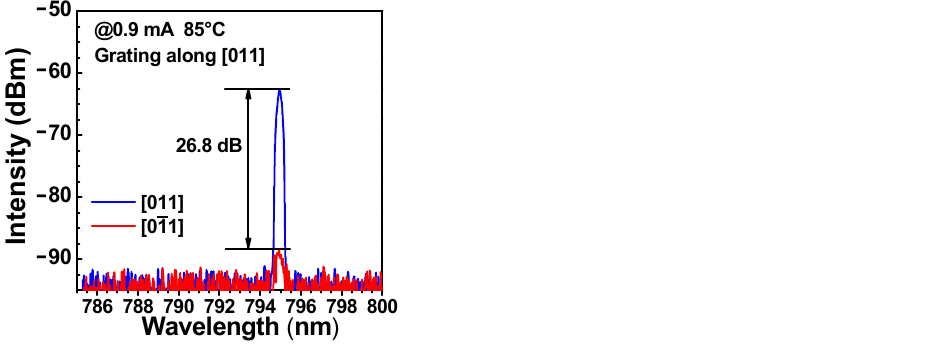
Figure 8. Polarization-resolved spectra of a 795 nm VCSEL at an injection current of 0.9 mA and 85 °C.